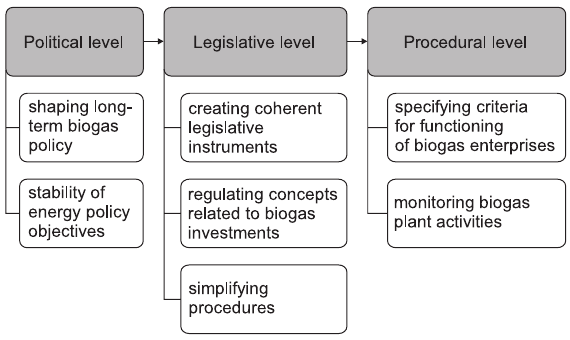
Fig. 2. Synergy of institutional solutions for the biogas market in Poland. Source: own study based on research